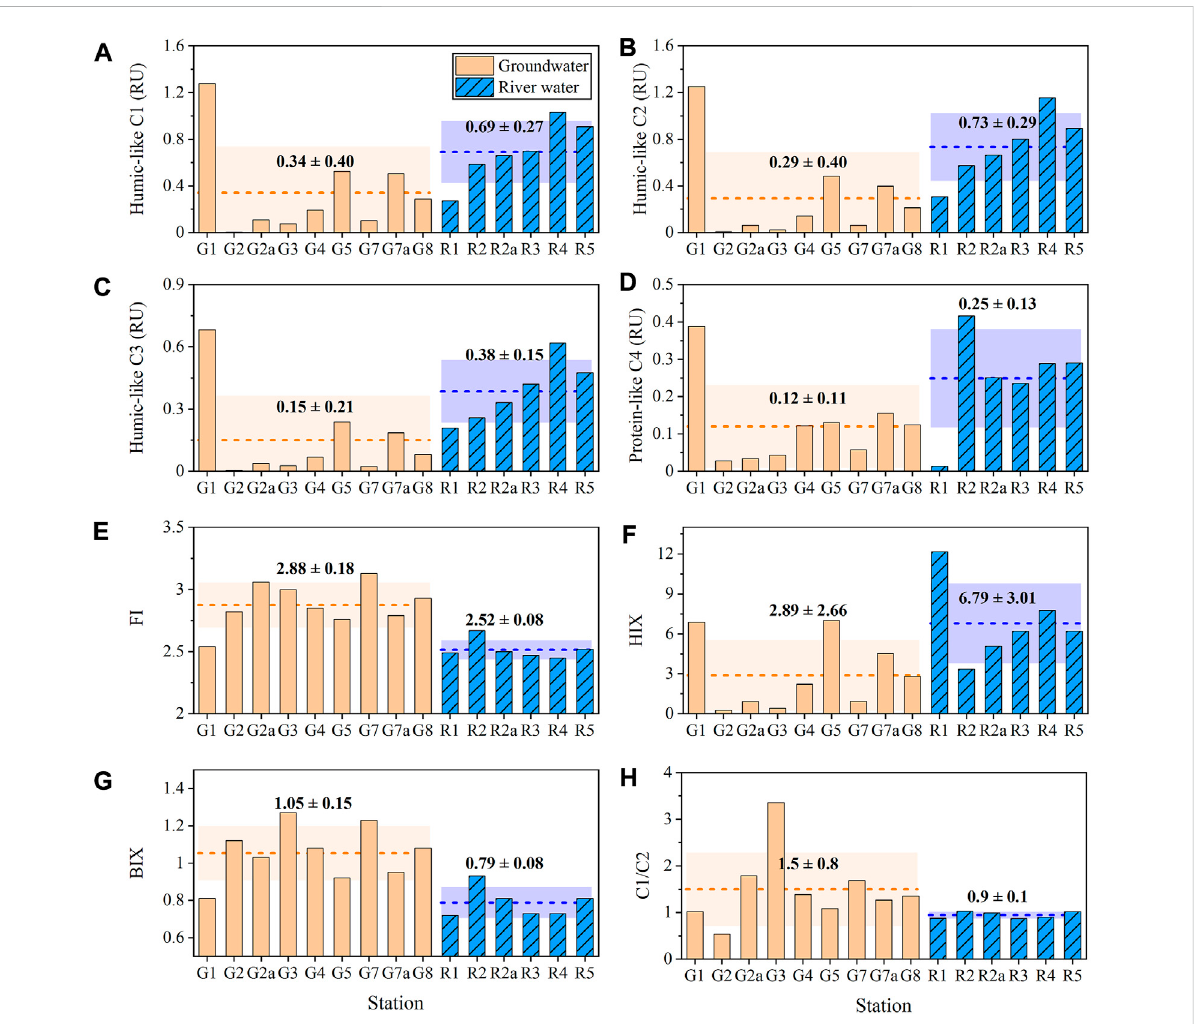
FIGURE 4 Distributions of (A) humic-like C1, (B) humic-like C2, (C) humic-like C3, (D) humic-like C4, (E) fl uorescence index (FI), (F) humi fi cation index (HIX), (G) biologicalindex(BIX)and (H) theratioofC1toC2(C1/C2)ingroundwaterandriverwatersamples.Thedottedlinesandshadowsdenotethe average values and standard deviations,